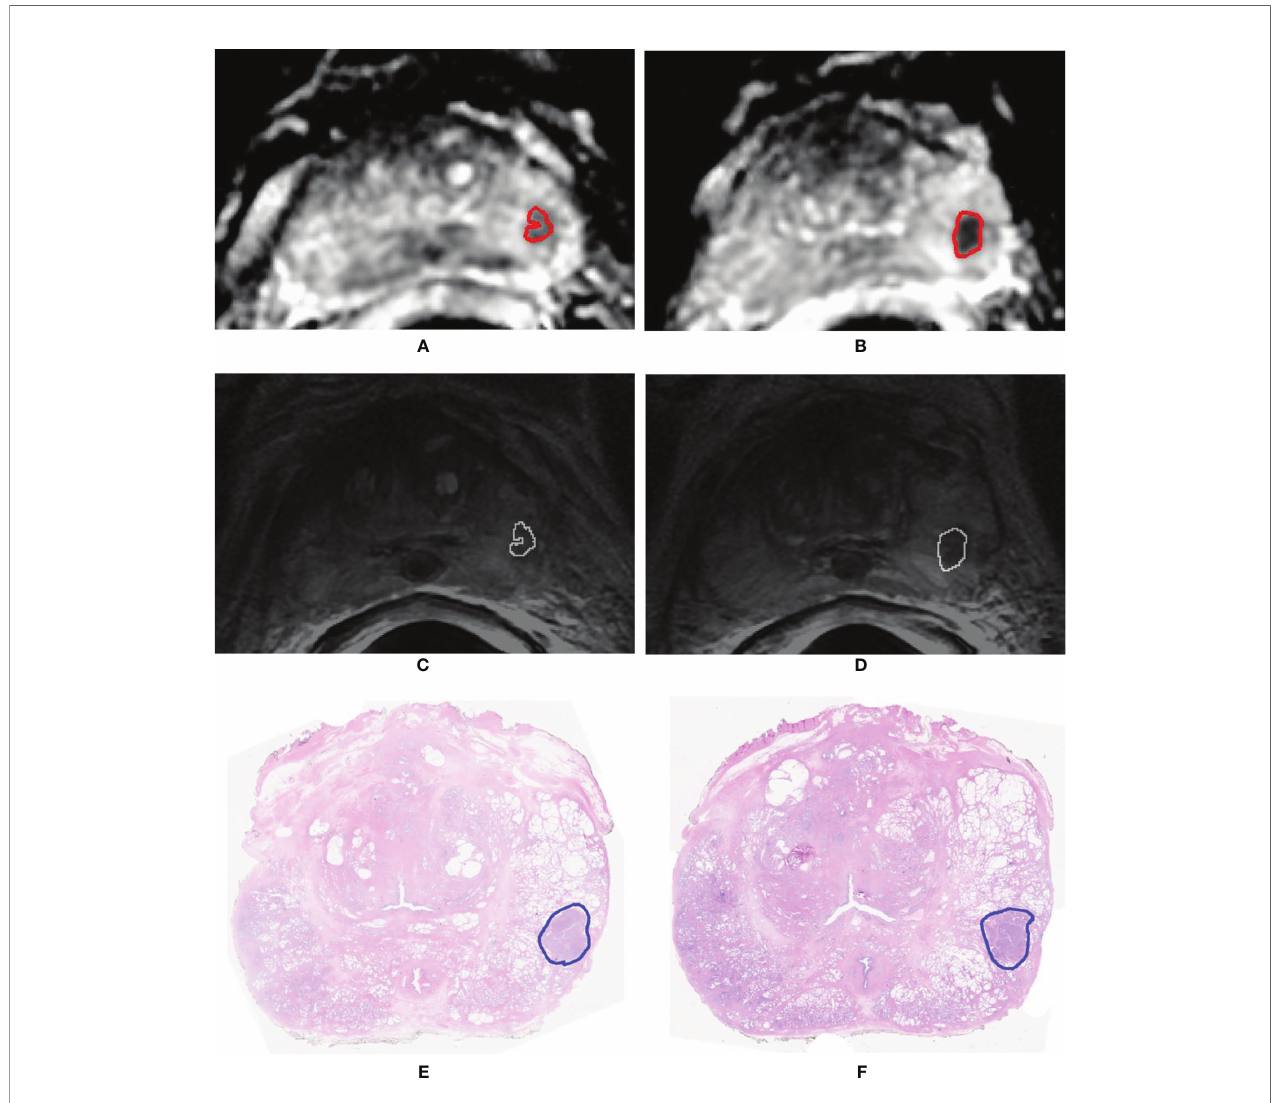
FIGURE 8 | Example of two slices of a GS = 4 + 4 (GG 4) prostate cancer having volume = 0.84 cm 3 that was erroneously classi fi ed as low aggressive. Segmentation mask superimposed to the apparent diffusion coef fi cient (ADC) map (A, B) and to the T2-weighted (T2w) image (C, D) . Histopathologic section of the tumor in which the pathologist drew the outline of the tumor (blue contour) (E, F)